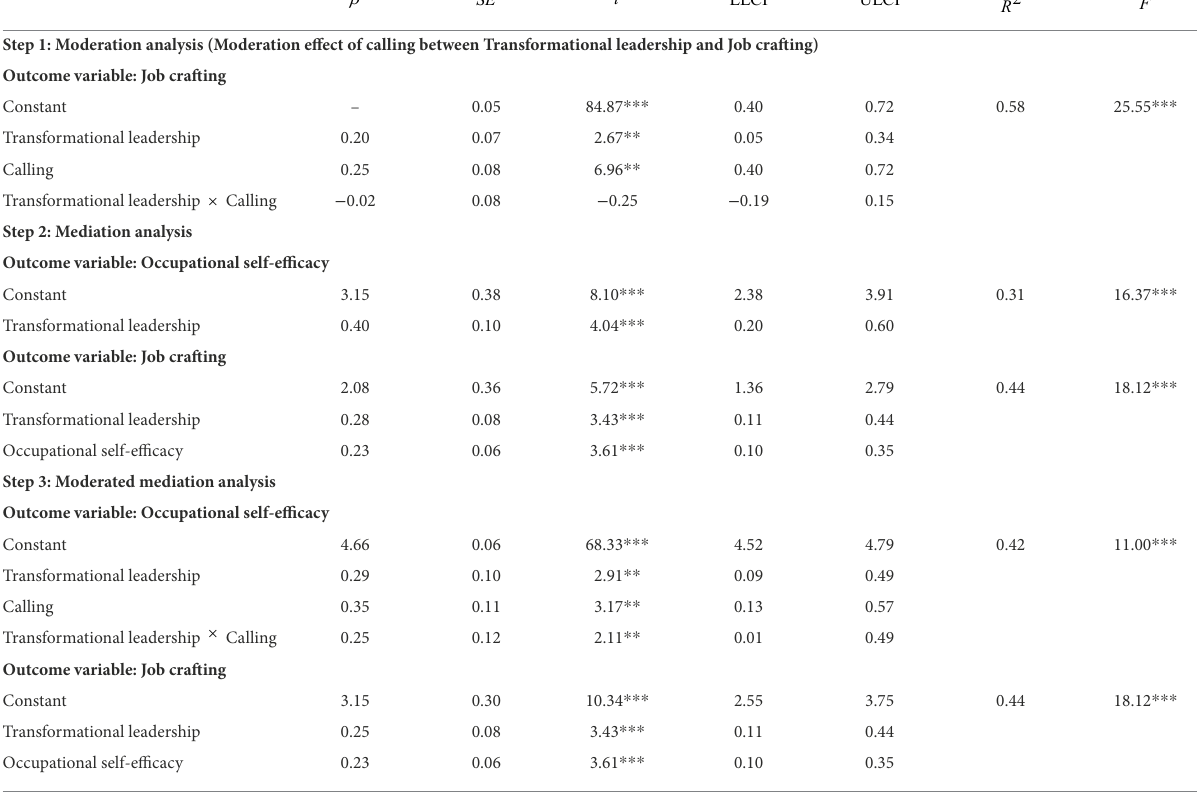
TABLE 3 The results for testing the